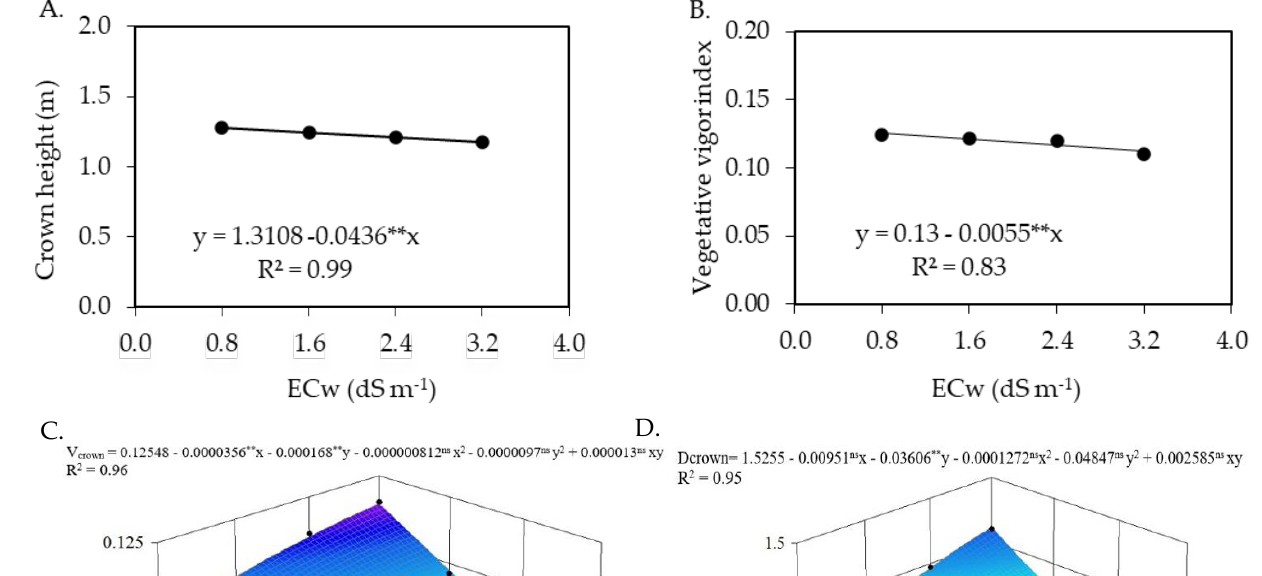
1.63 ns , * and ** are, respectively, not significant and significant at p ≤ 0.05 and ≤ 0.01. CV: coefficient of variation; DF: degrees of freedom. The salinity of irrigation water negatively affected the crown height (Figure 4A) and